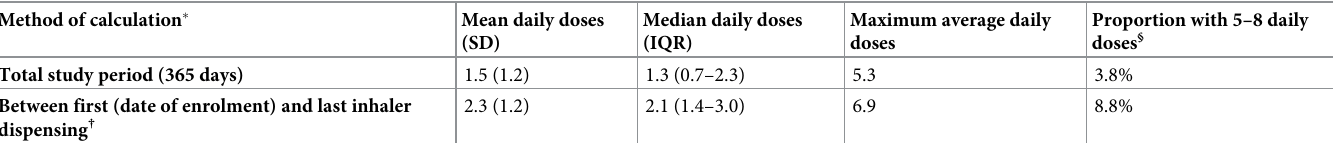
Table 3. Average daily doses of budesonide-formoterol (N =